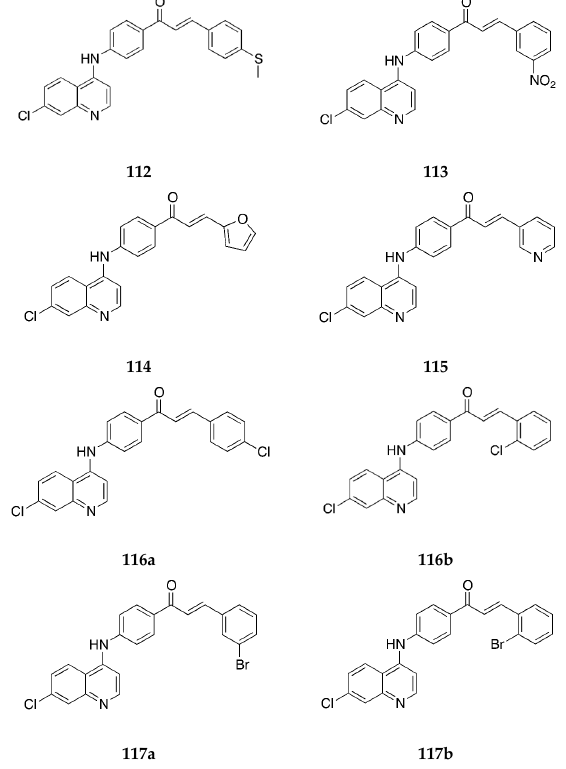
Figure 47. Chemical structures of quinolinyl-4-aminochalcones derivatives.